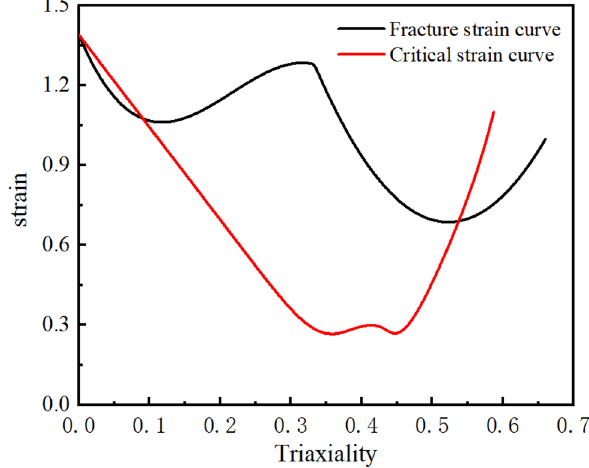
Figure 8 Equivalent fracture strain curve and equivalent critical strain curve after